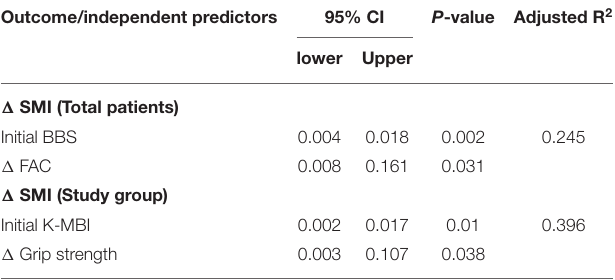
TABLE 5 | Multivariate linear regression analysis related factors for changes in